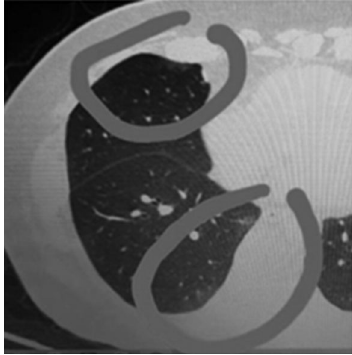
Figure4.CT-scanchest/lungwith128slicesofthepatientonthe12thdayoftreatment. Circlesindicateground- glass appearance on the right lobe lung.